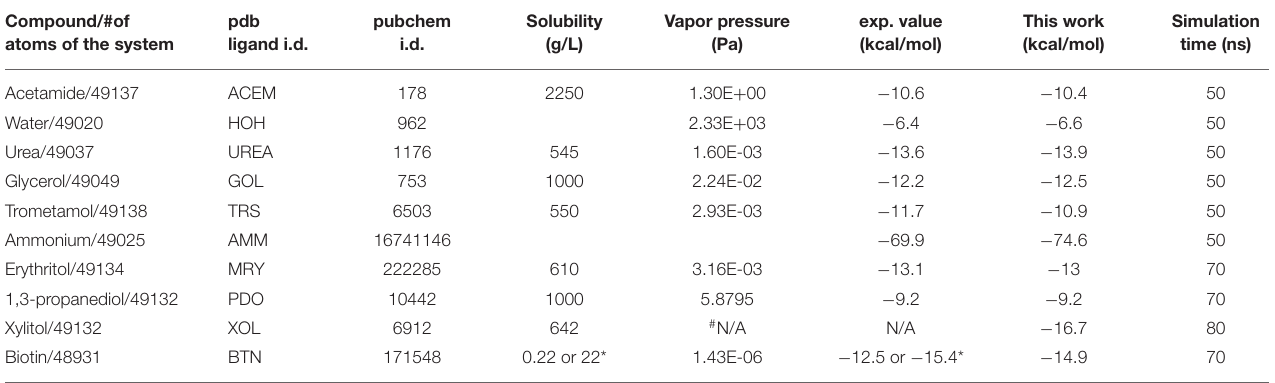
TABLE 2 | Experimental vs. computed hydration energies. Compound/#of atoms of the system